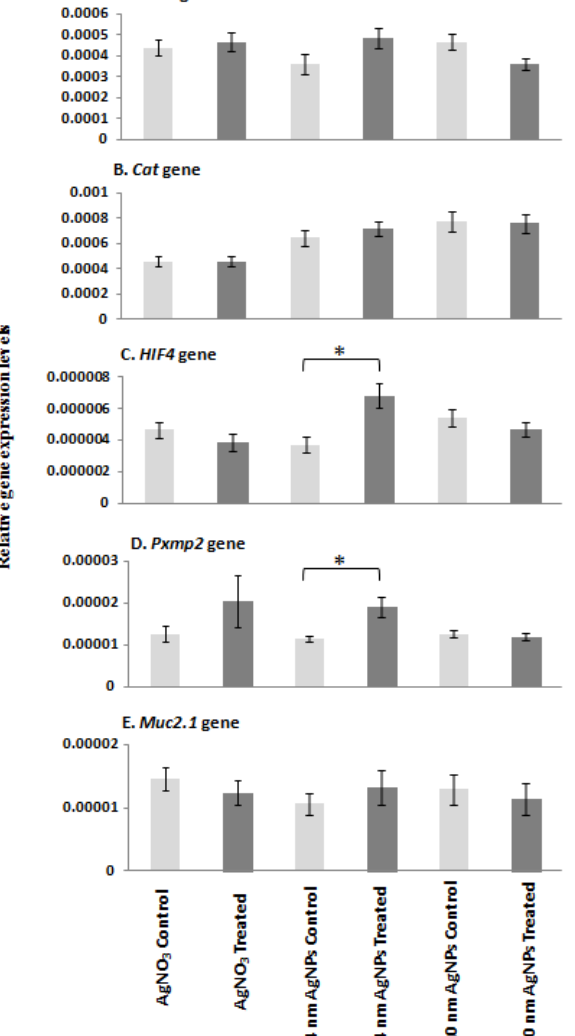
Figure 5. qPCR mRNA transcript levels for ( A ) SOD2 , ( B ) CAT , ( C ) HIF4 , ( D ) Pxmp2 and ( E ) Muc genes in zebrafish embryos at 96 hpf following exposure to AgNO 3 (18 µg/L Ag+), S4 AgNPs (1.925 mg/L), and S10 AgNPs (1.925 mg/L). Values represent mean ± standard error. * significant difference between samples and the control groups using either two-sample t-test or Mann–Whitney test. * p < 0.05. n = 4.